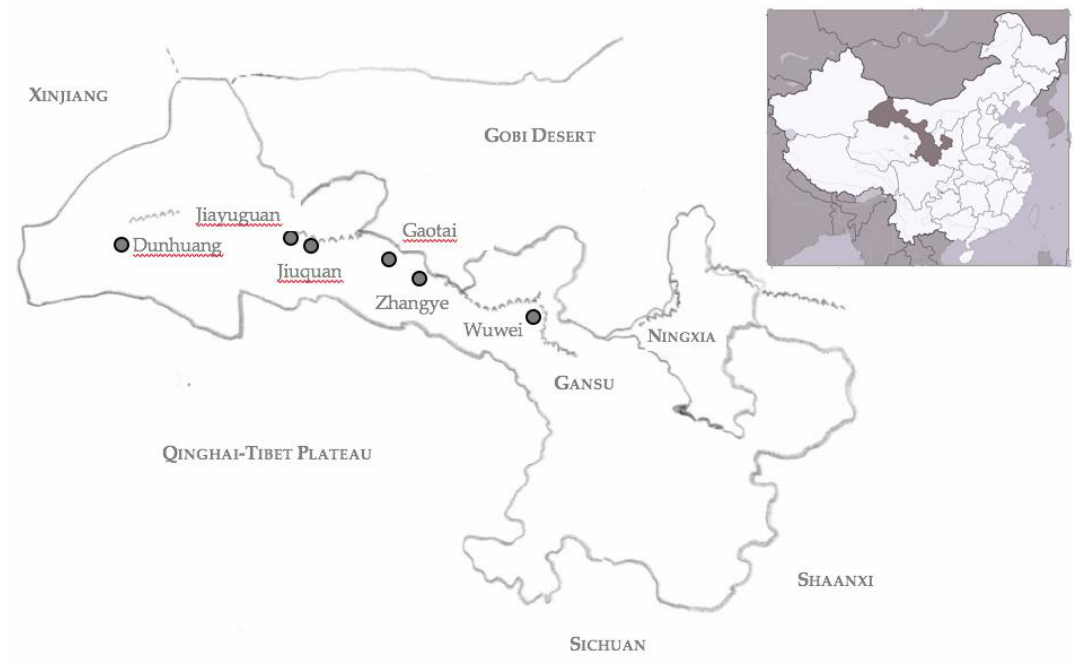
Figure 1. Oasis cities of the Hexi Corridor in Gansu province. 2